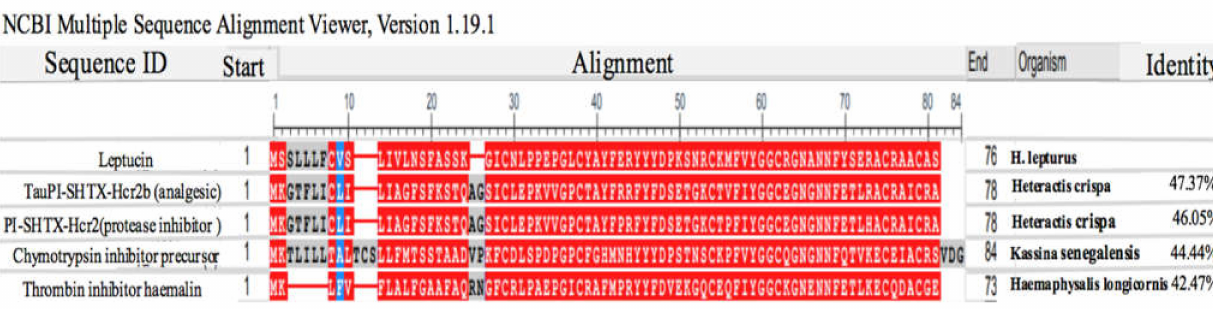
Figure 2. Multiple alignment of leptucin with selected similar peptides by COBALT server. Leptucin’s ORF was compared to its closest similar peptides. As shown in the figure, that was similar to different peptides with identity ranging from 47.37 to 42.47%. Also, analysis showed a conserved signature sequence in the selected similar sequences as [C (6XGX) C (8XYXD5X) C (2XFXYGG) C (XGNXNNF5X) C (3X) C